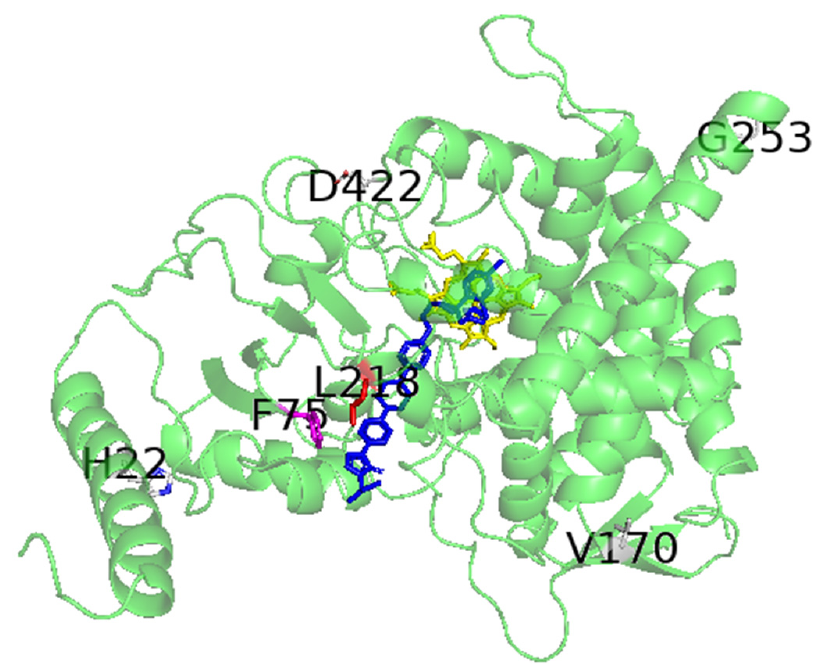
Figure 1. Calculated model of FSSC CYP51A protein. Point mutations shared by all FSSC strains and known to be associated with azole resistance in A. fumigatus are indicated by the amino acid letter and position. Amino acid L218 interacts with F75, and both are present at the entry of the substrate channel (yellow: heme; blue: itraconazole; purple: F75; red: L218, corresponding to the channel entry for the substrate). Table 7. Mutations of interest observed in FSSC strains, corresponding amino acids, physicochemical properties, and their impact on azole resistance (A: apolar; P: polar uncharged, − : negative polar; +: positive polar; ATU: area of technical uncertainty, R: resistant, n/a: data unavailable).